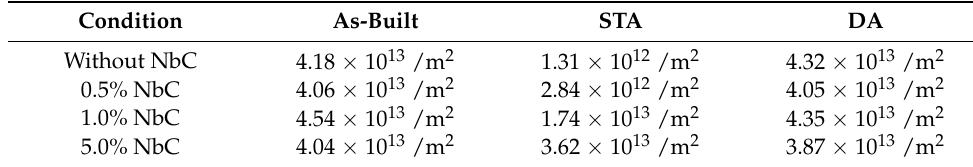
Table 6. Overall GND density of different specimens.